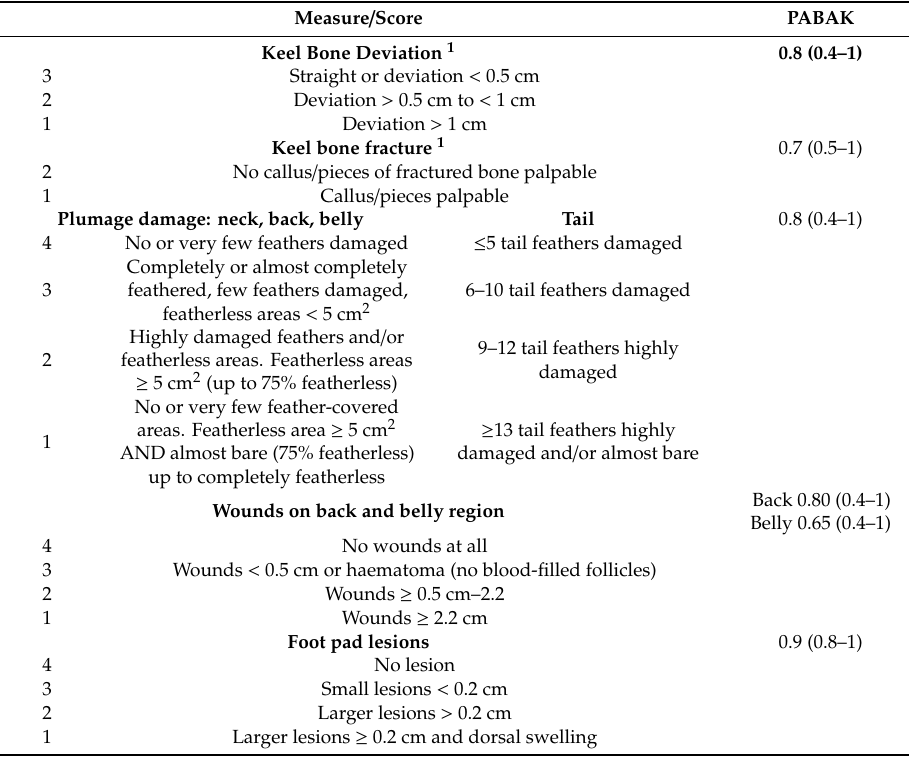
Table 1. Scores and definitions for the assessment of keel bone status, plumage status, skin lesions and foot pad lesions (in bold) in laying hens and achieved inter-assessor reliability (prevalence-adjusted bias-adjusted kappa values: PABAK).